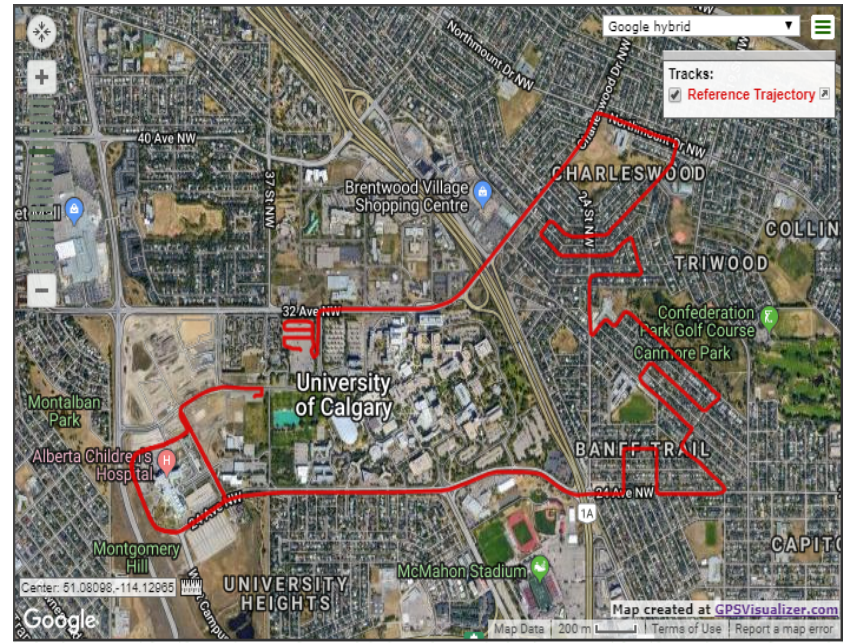
Figure 3. The first test trajectory of SF-PPP/INS integration, Calgary, Alberta,